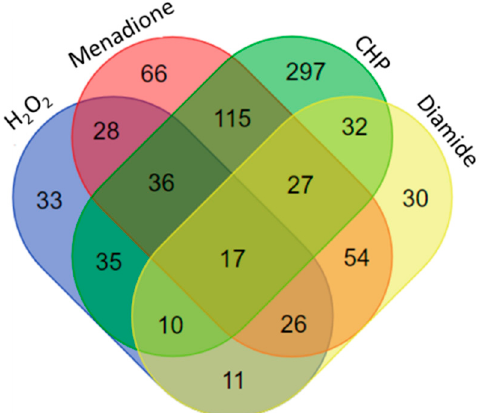
Figure 1. Venn diagram showing unique and shared proteins significantly regulated ( p < 0.05) by H 2 O 2 , hydroperoxide (CHP), menadione, and diamide 3 min post treatment. Data was analyzed using Proteome Discoverer 2.4 using label-free quantification relying on precursor ions of tryptic peptides based on high-resolution (Orbitrap) mass spectrometry.